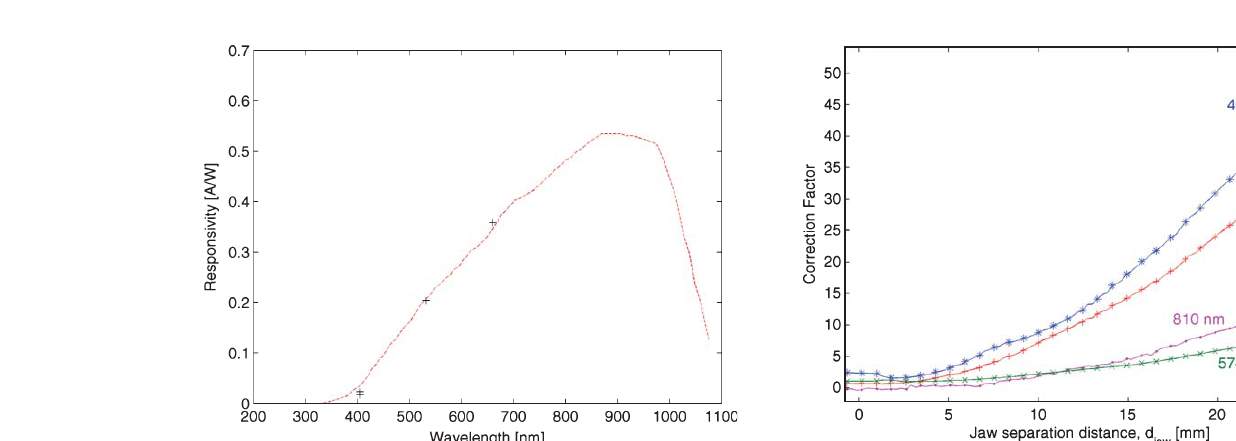
nal magnitude and phase were measured at the detector input at frequencies from 1 kHz to 5 MHz.